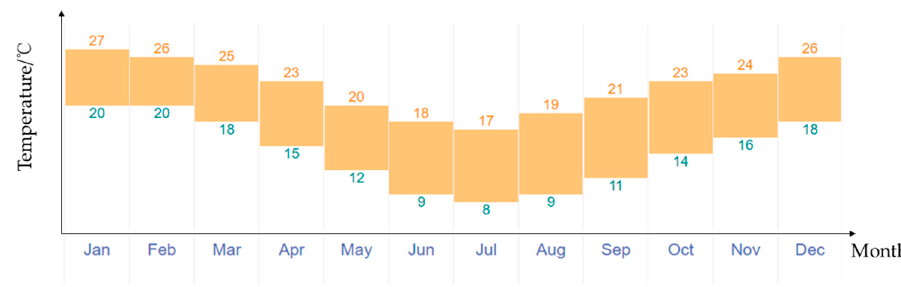
Figure 10. The all-year climate (annual weather averages) in Sydney.